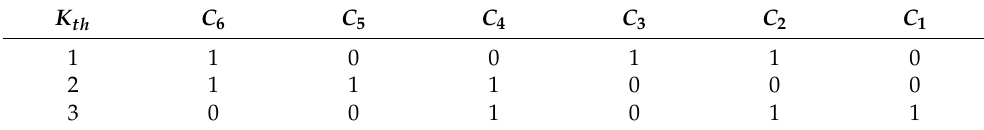
Table 2. Basic EDW code sequence for W = 3 [20].